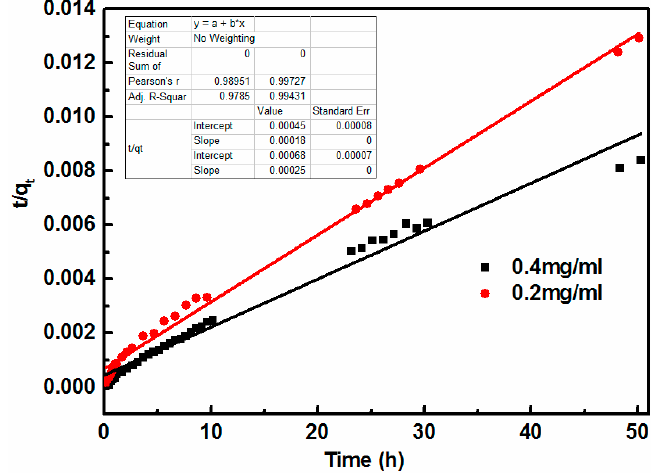
Figure 5. Pseudo second-order kinetics with different GO concentrations.